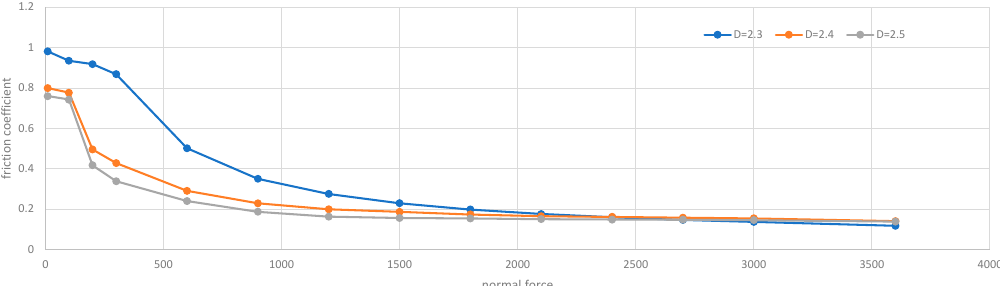
Figure 8. Simulation results of the friction coefficient for different normal forces and fractal dimen- sions.